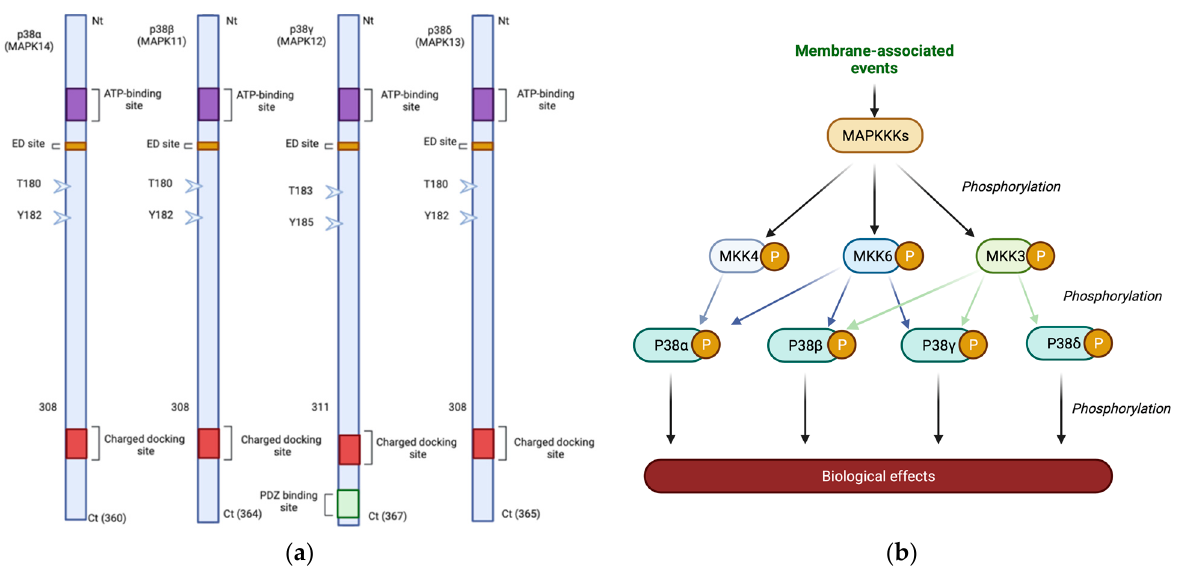
Figure 1. p38 MAPK diversity in structure and activation. ( a ). Diagram of the four human p38 kinases, indicating amino acid numbers and the different domains: The CD-charged docking domain is a negatively charged region involved in high-affinity docking interactions with positively charged substrates. The ED domain contributes to substrate docking. The ATP binding site and the phos- phorylated Thr and Tyr residues of the activation loop are also indicated. The PDZ binding site is a protein–protein interaction motif exclusive to p38 γ . ( b ). Diagram of the MAP2Ks and their specificity for the different p38MAPKs.